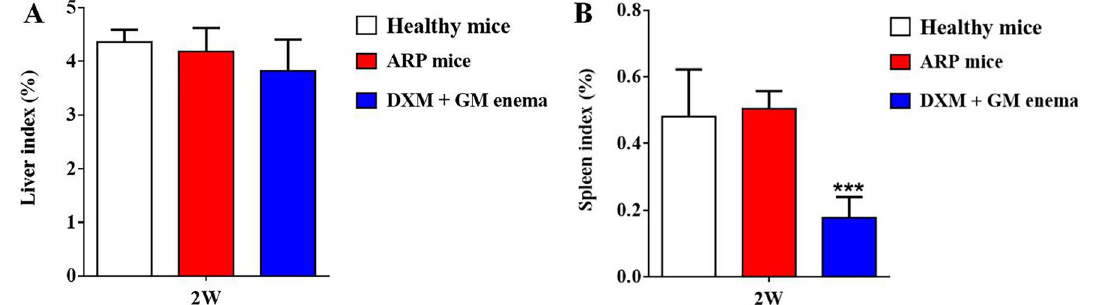
Figure 2. DXM + GM enema reduces spleen index while has no effect on liver index. ( A ) There was no significant difference in liver index at 2 weeks among healthy mice and ARP mice treated with or without DXM + GM enema. ( B ) Compared with healthy control group mice, the spleen index of mice treated by DXM + GM enema at 2 weeks was reduced in response to radiation ( ***P <